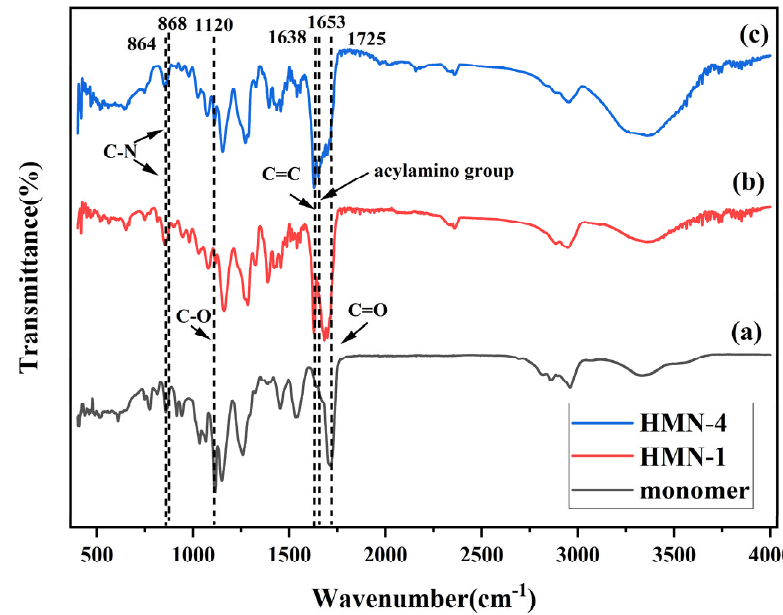
Figure 1. FTIR spectra of ( a ) monomer, ( b ) HMN ‐ 1, and ( c ) HMN ‐ 4.